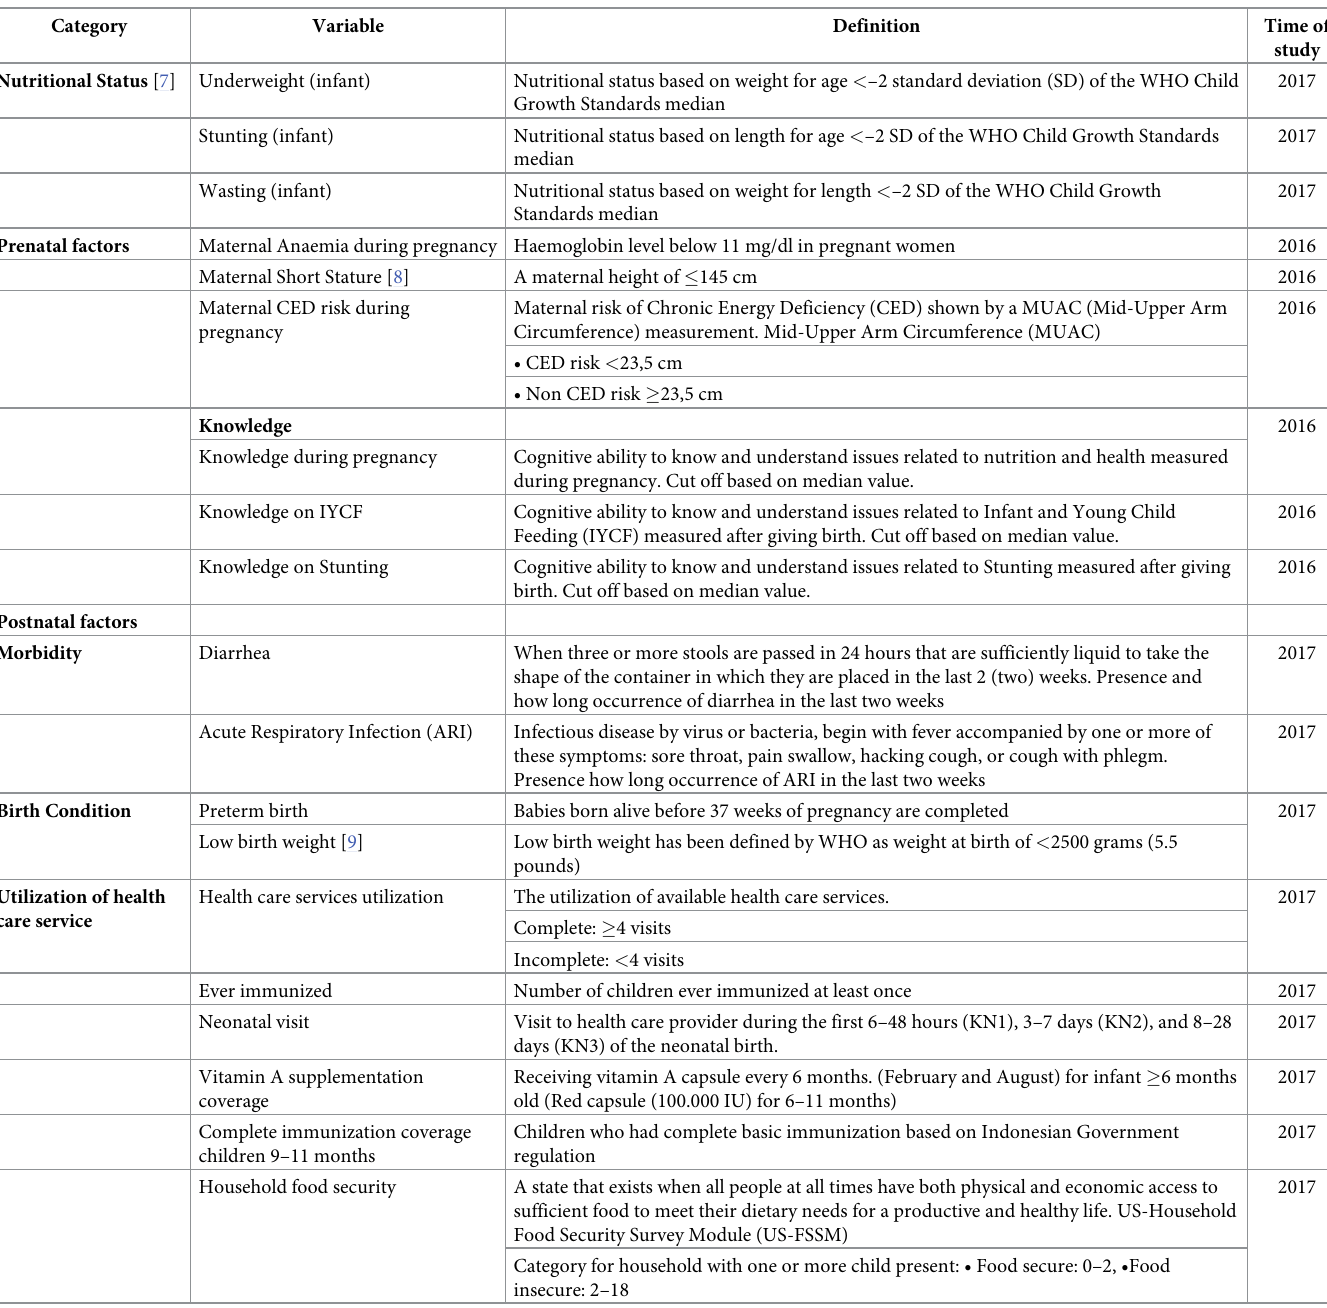
Table 1. Variables and operational definition.